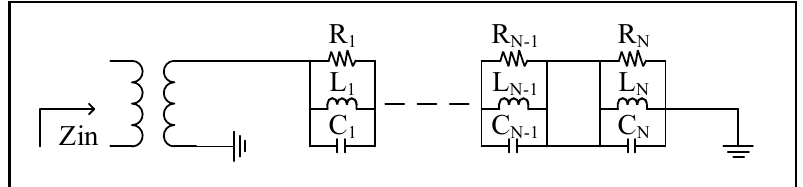
where C eq is the total equivalent capacitance and can be obtained by summing up the capac- itances generated by individual leg of the V-shaped slot. L eq is the equivalent inductance generated by the etched slot and can be calculated by using the following relation: